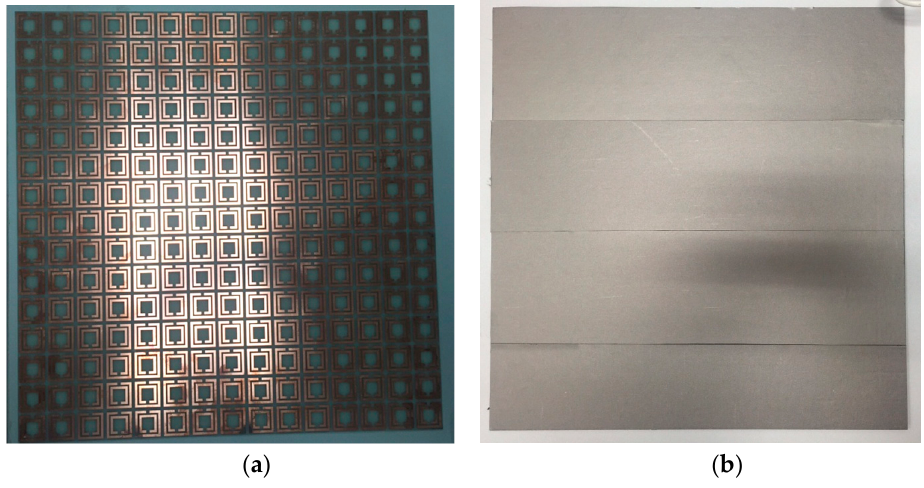
Figure 5. Prototypes of metamaterials with and without ferrite film ( a ) The picture of a slab of 15 mm × 15 mm units of SRR metamaterials; ( b ) the 15 mm × 15 mm units SRR metamaterial slab covered by a layer of 0.3 mm thick ferrite film.